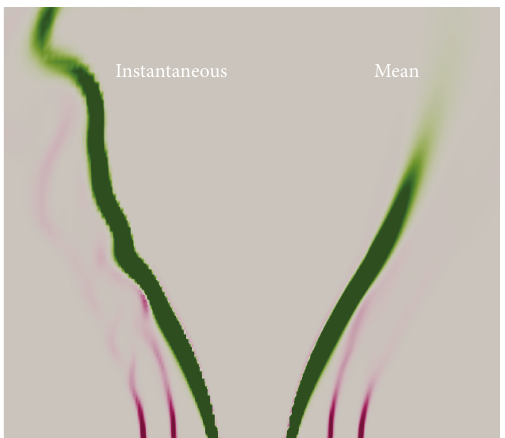
Figure 19: Snapshot of instantaneous and mean G value contour behind the blu ff body (green, positive; purple, negative; and gray, zero).